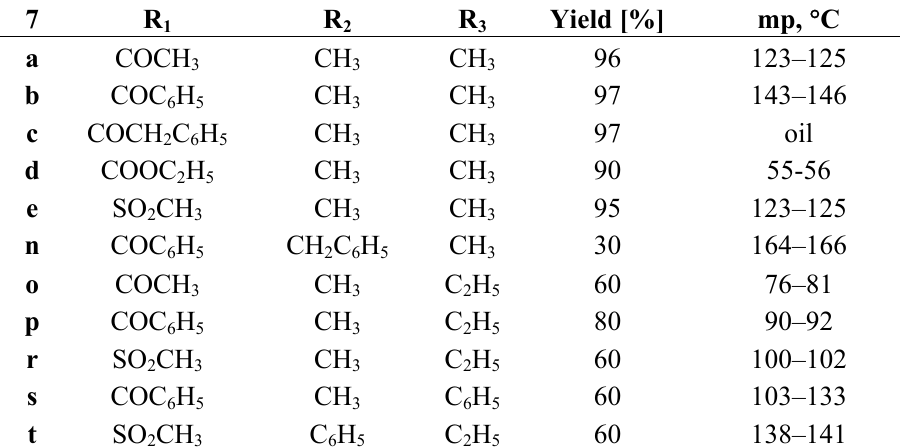
Table 5. Cyclisation to 1,1-disubstituted